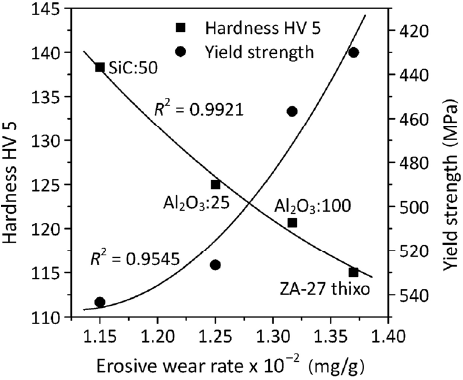
Fig. 5 Erosive wear rate vs. hardness and compressive yield strength of tested